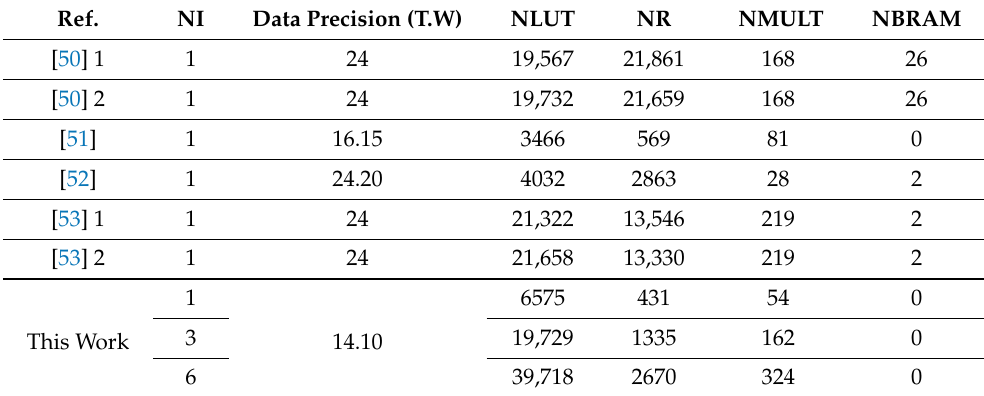
Ref. NI Data Precision